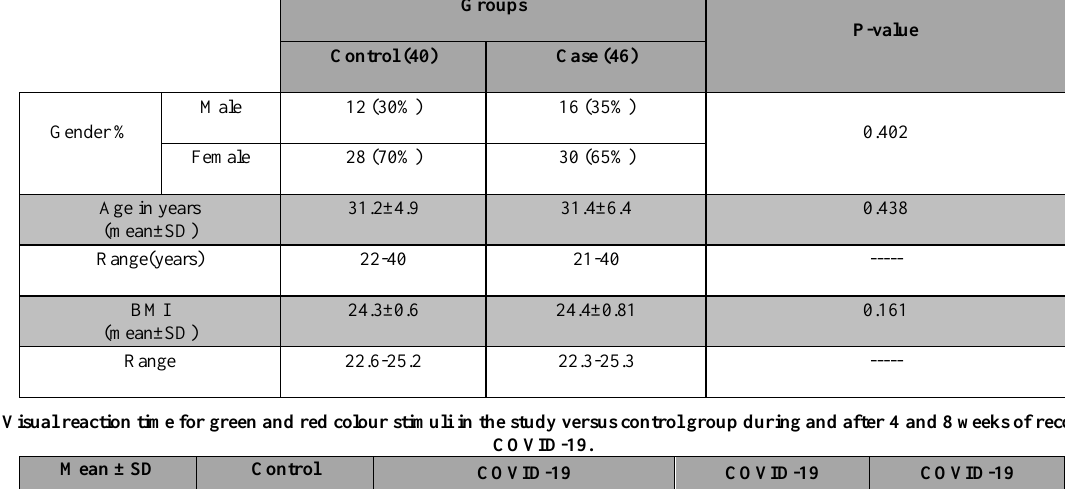
Table 1. Demographic and anthropometric details of the study (case) and control groups.